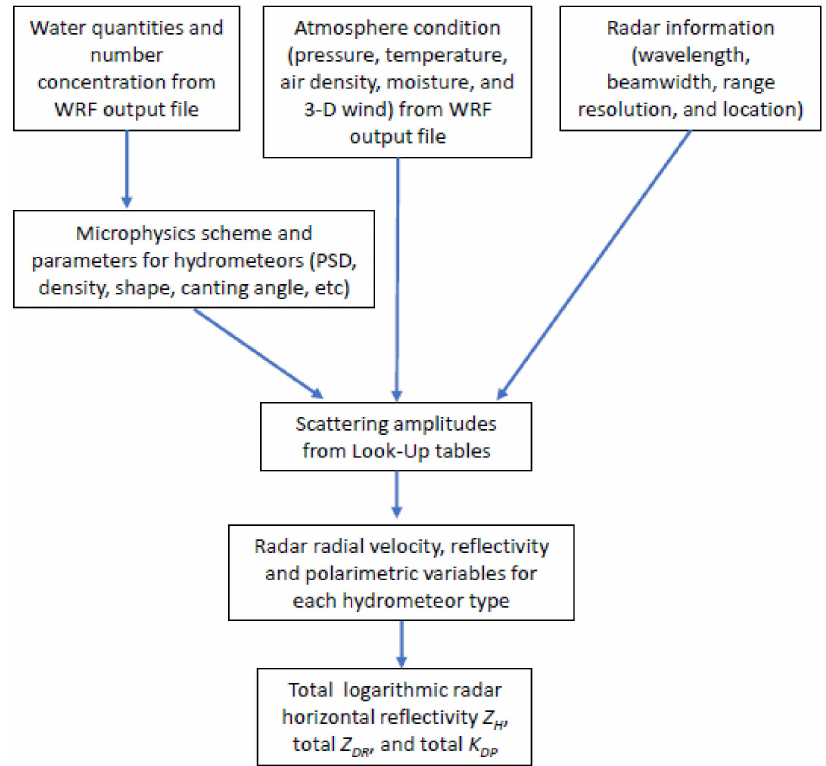
Figure 1. Flow chart of the radar forward